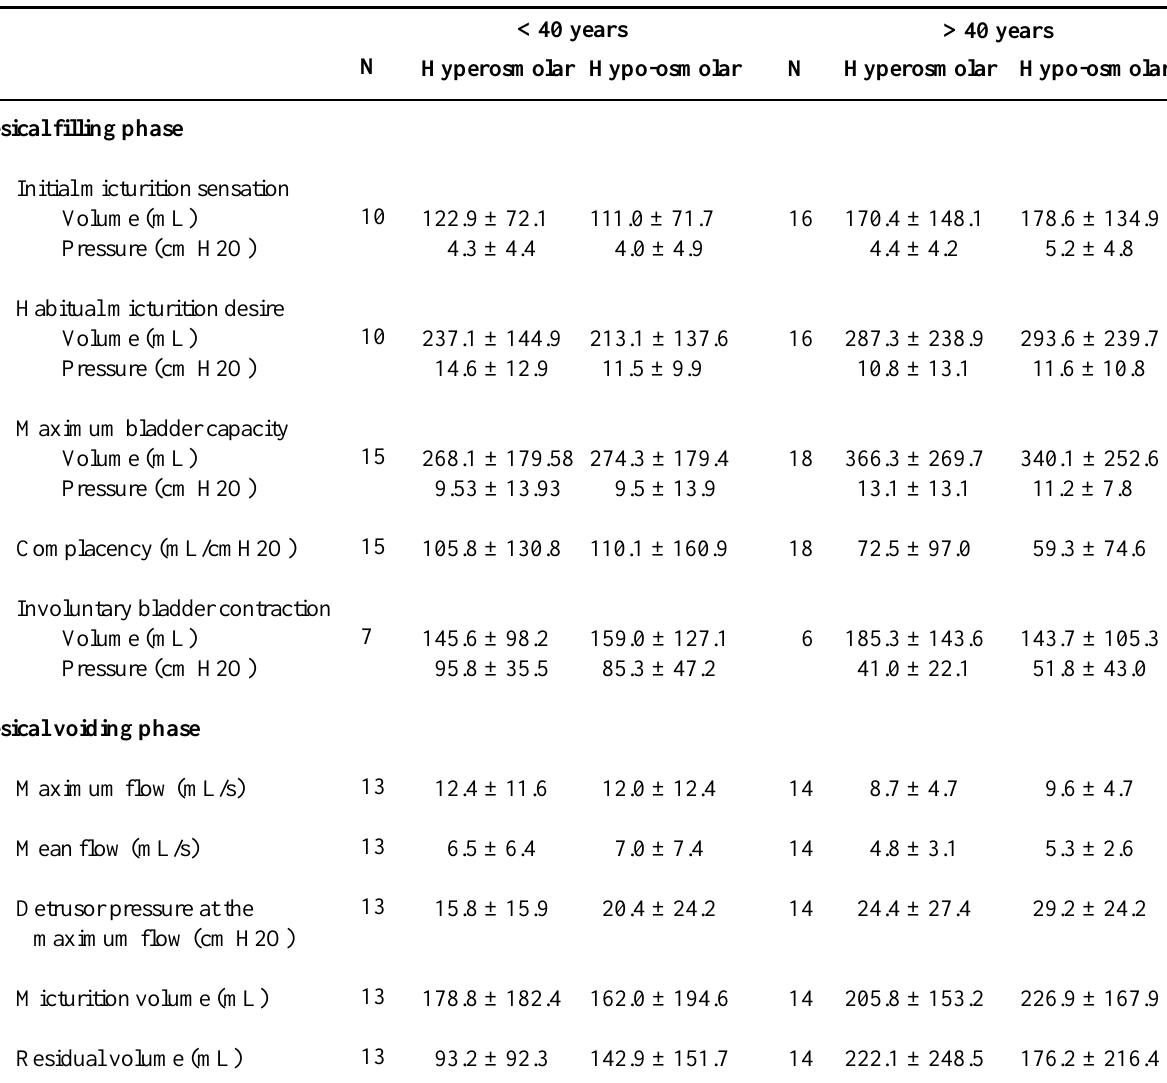
Table 2 – Values of urodynamic variables when vesical filling is accomplished with hyper- and hypo-osmolar solutions in patients with age inferior and superior to 40 years-old (mean ± standard